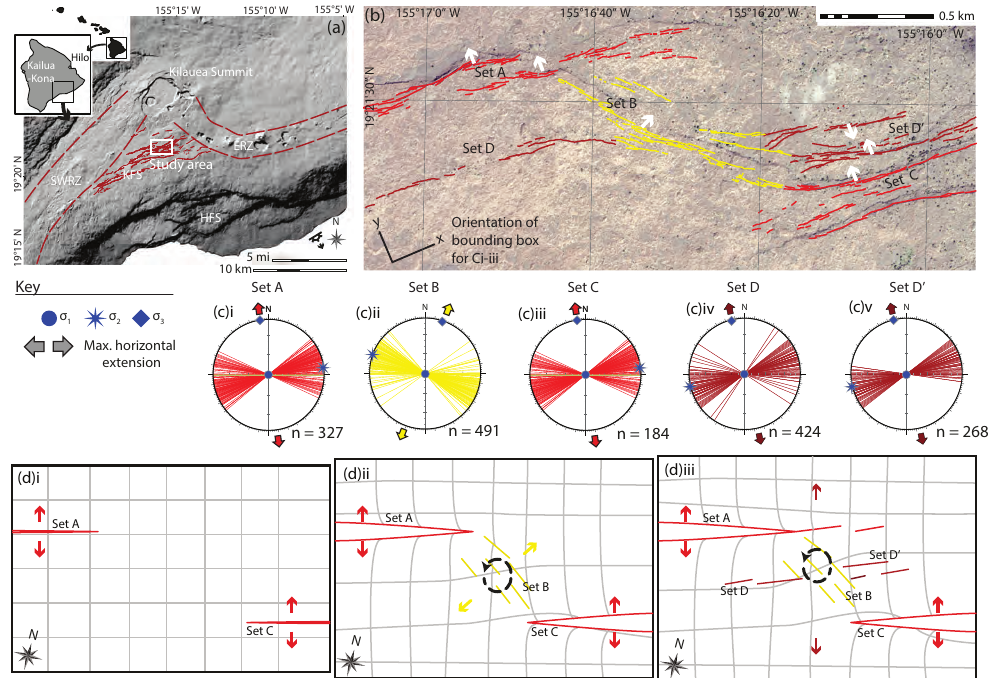
Figure 3. (a) Simplified structural element map of K¯ılauea Volcano, showing the study area within the Koa‘e fault system (KFS). ERZ: East Rift Zone. SWRZ: Southwest Rift Zone. HFS: Hilina Fault System. Inset shows relative position of A, on the south coast of the island of Hawai‘i. (b) WorldView-2 image of the study area showing the distribution and orientation of mapped fractures. White arrows indicate dip directions of monocline limbs and fault scarps. (c) Lower-hemisphere stereographic projections showing measured fault and/or fractures as planes and measured extension directions for each of the three structural sets. (d) Proposed schematic evolution of fault sets: (i) propagation of the main rift-fault set (sets A and C); (ii) interaction between sets A and C produces deficits of heave displacement, requiring vertical axis block rotation in the relay zone, and local reorientation of extension direction (set B); and (iii) development of new rift-parallel structures (set D; Swanson et al., 2017). The bounding box is aligned with first-order rift faults (sets A and